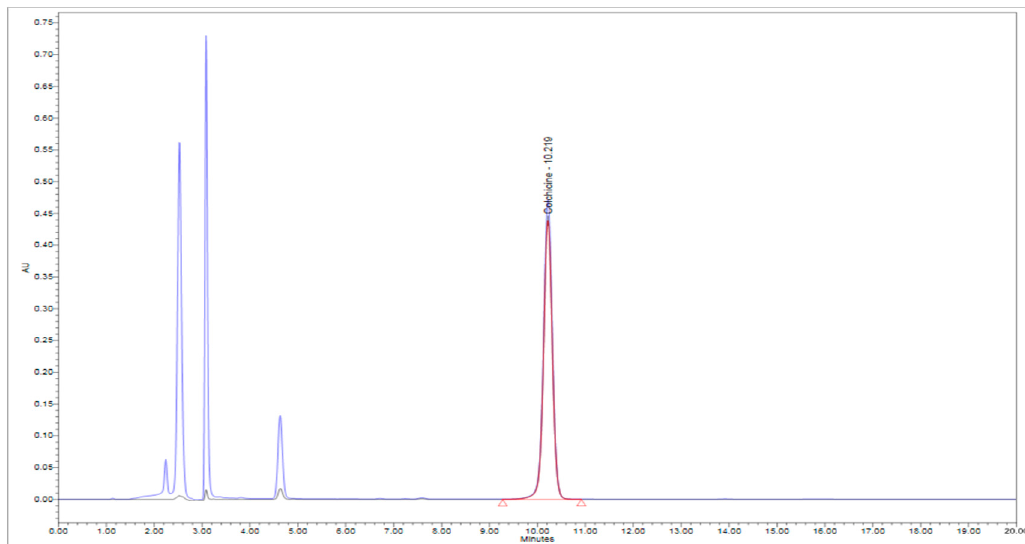
Figure 2. HPLC Chromatograph of the Colchicine standard and the Gloriosa seed extract.